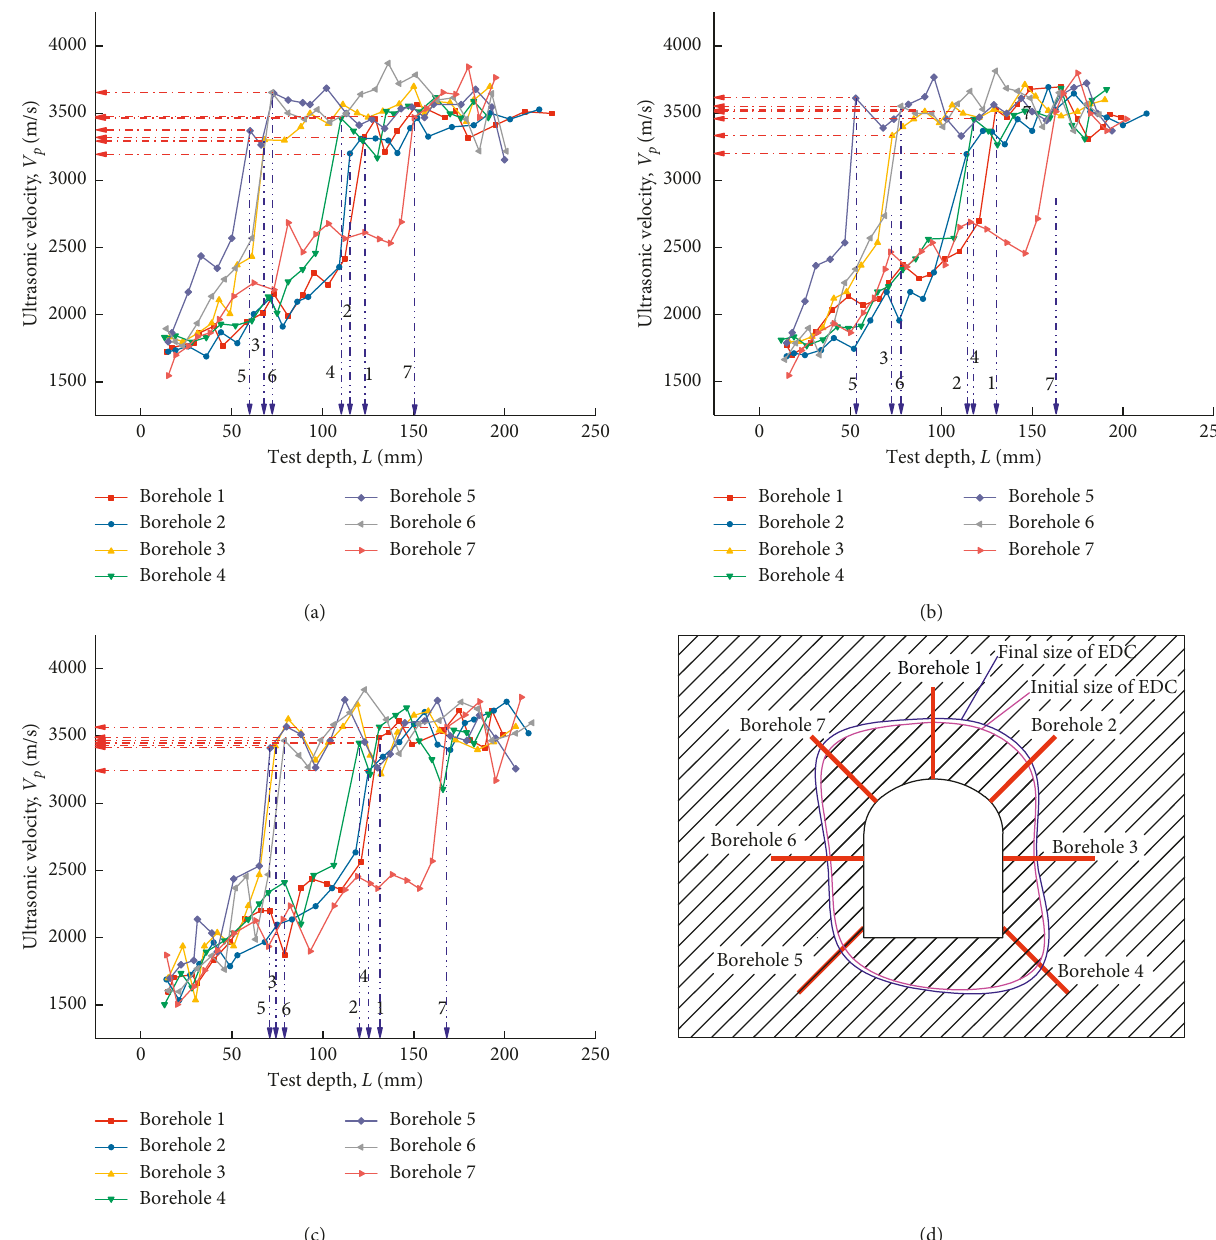
Figure 5: Relationship between V p and L of different dates in Section 1: (a) test results on March 18, (b) test results on March 26, (c) test results on April 3, and (d) initial size and final size of the